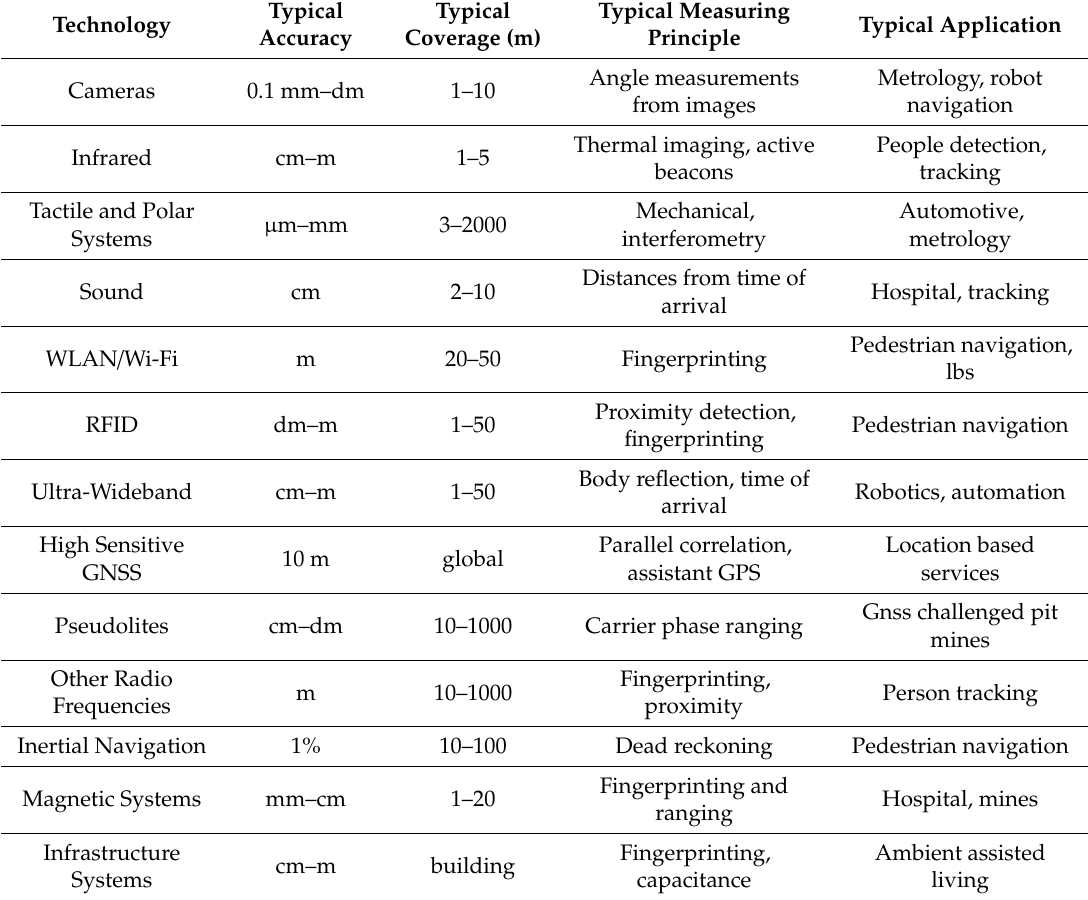
Table 1. Overview of the indoor positioning technologies [1].